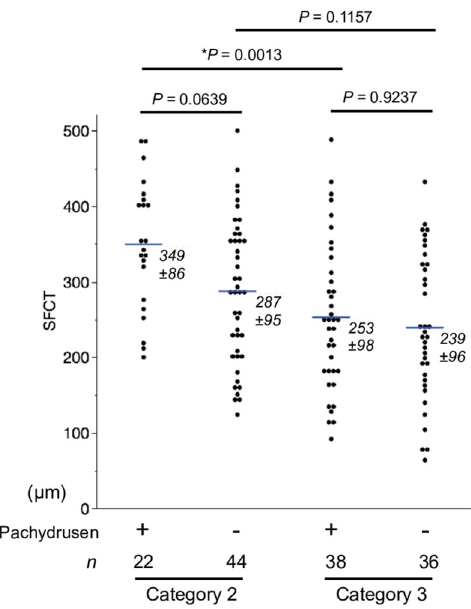
Fig 5. Scatter plots for SFCT of Category 2/3 in the presence or absence of pachydrusen. Horizontal blue bars indicate the mean SFCT in each group (SDs are numerically shown). � P < 0.05. Tukey-Kramer HSD test.